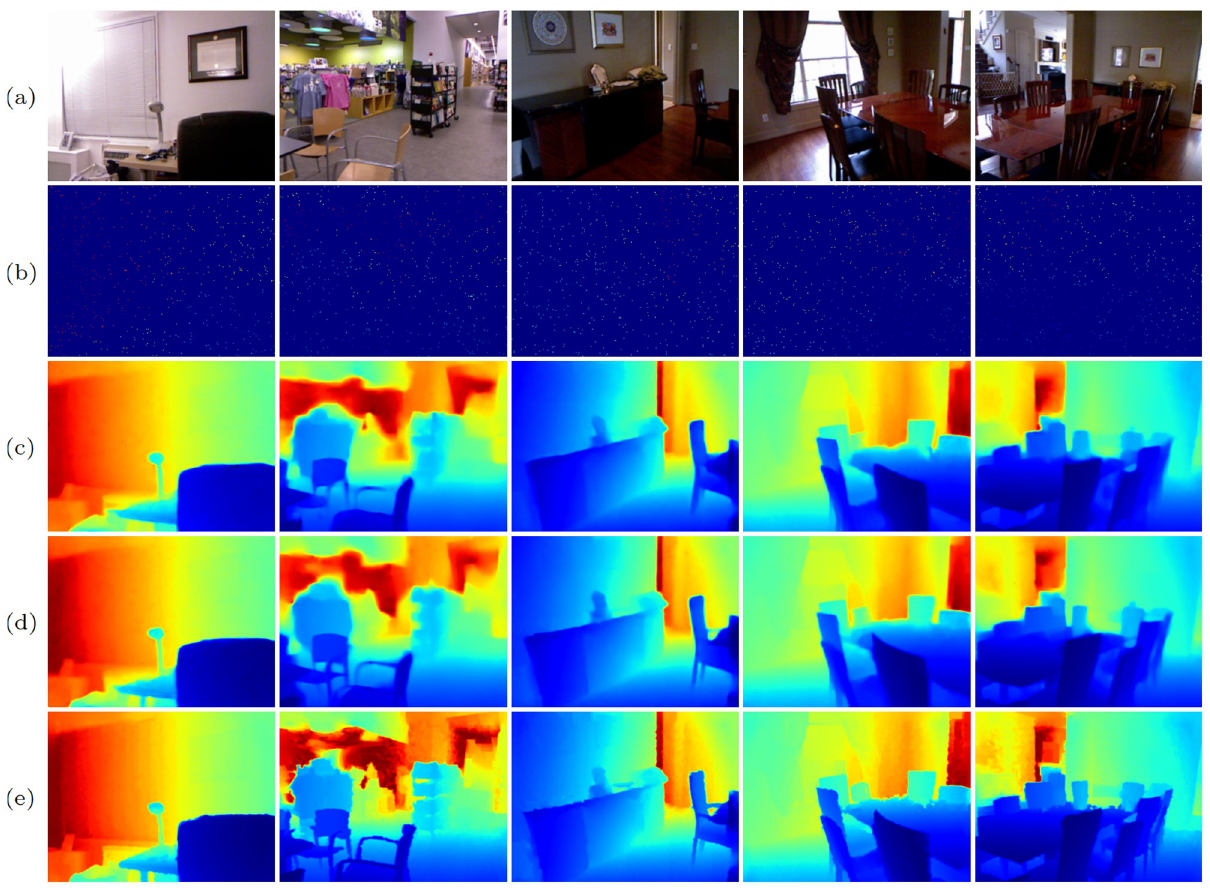
Fig 7. The effectiveness of multi-scale gradient extractor. (a) RGB, (b) sparse depth, (c) baseline, (d) model C, (e) GT.